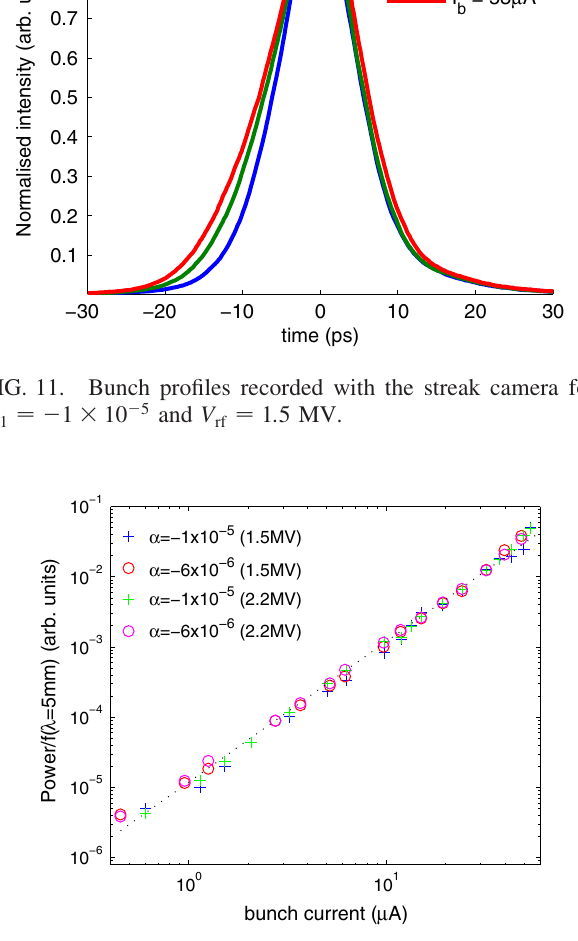
FIG. 12. Power measured with the Schottky barrier diode normalized to the form factor calculated using the bunch profile measured using a streak camera. The power normalized in this way becomes independent of machine parameters and propor- tional to I 2 b , consistent with steady-state coherent emission.